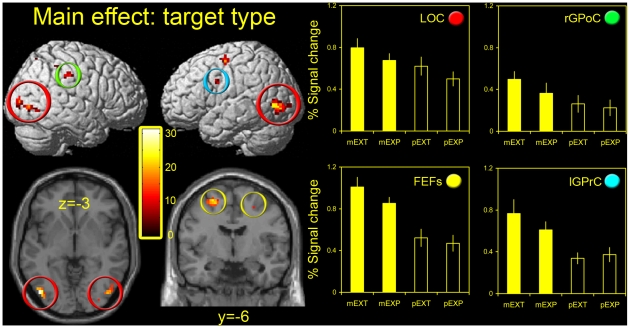
Whole brain analyses – main effect of target type.Two left panels: group level activations are shown for the main effect of target type (P<0.001 uncorrected) overlaid on either a T1-weighted structural image rendered in stereotactic space (upper panels) or selected axial and coronal slices (lower panels). In the right panels, estimates of BOLD signal changes from the GLM analysis (relative to rest) for the group of participants are shown for the 4 experimental conditions (mEXT, mEXP, pEXT, pEXP) for the main clusters of activity (two right panels). Error bars represent one standard error of the mean. The colored patches in the upper right corner of the graphs are color coded to match the colored rings in the left hand panels, which denote defined loci in the brain slices and whole brain projections, e.g. red rings illustrate the location of the LOC in the brain slices, and the red circle denotes the accompanying signal plot for that region. LOC – lateral occipital cortex (red rings); FEFs – frontal eyefields (yellow rings); rGPoC – right post-central gyrus (green ring); lGPrC – left pre-central gyrus (blue ring).